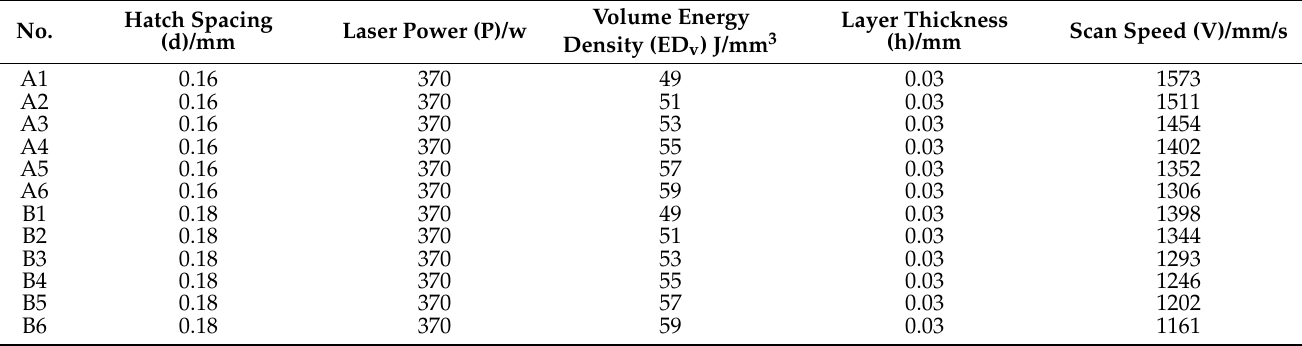
Table 2. Processing parameters of SLM.